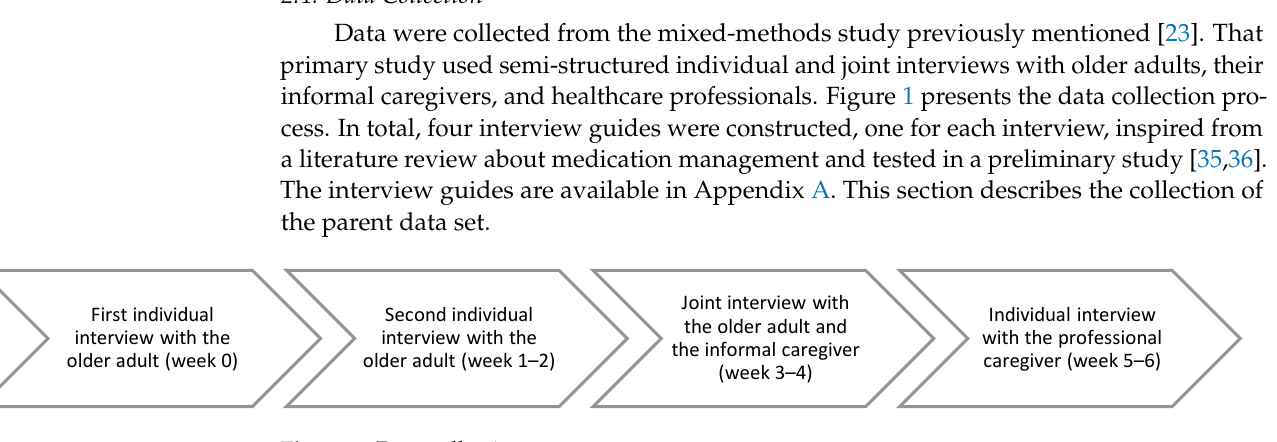
5 Table 1. Inclusion and exclusion criteria for different groups of participants. Participants